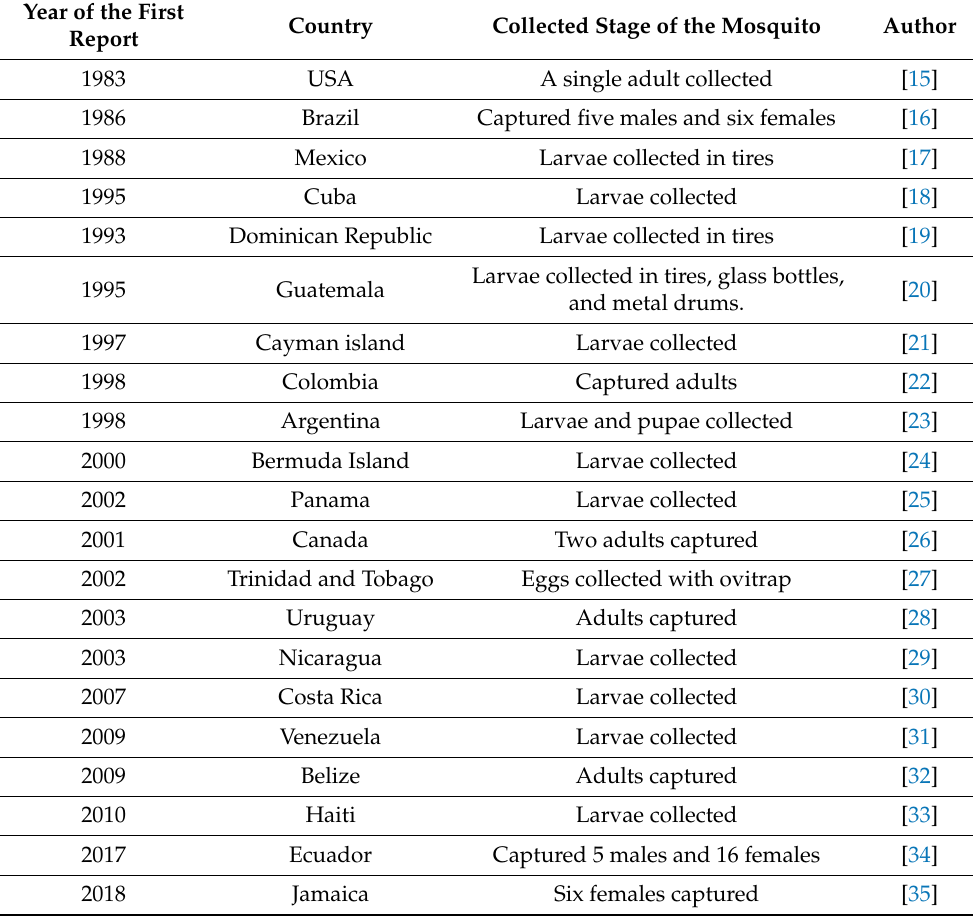
Table 1. Chronological summary of publications on the first reports of Ae. albopictus in American